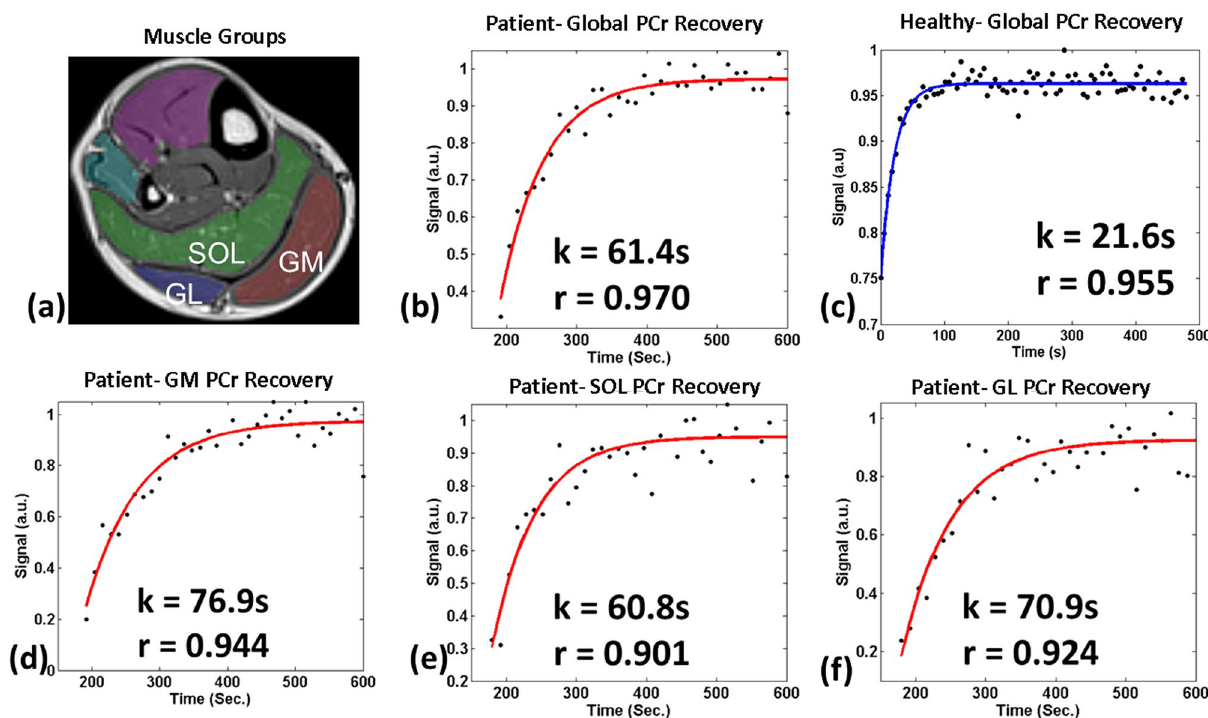
Figure 4. Global and regional PCr recovery using PCr imaging. ( a ) shows an image of calf muscle for anatomical reference and the muscle ROIs drawn for soleus (SOL), gastrocnemius medial (GM) and gastrocnemius lateral (GL). Sub-figures ( b ) and ( c ) show global and regional PCr recovery time constraints assessed using 31 P-MRI data from a representative HF patient and healthy volunteer by fitting phase III data to Eq. 1. The PCr recovery time constants are significantly delayed (~ 60–70 s) compared to healthy volunteers (~ 20- 25 s). The PCr recovery time in specific muscles (d) GM (e) SOL and (f) GL shows increased depletion and slower recovery in GM and GL muscle groups, suggesting glycolytic metabolism from type II